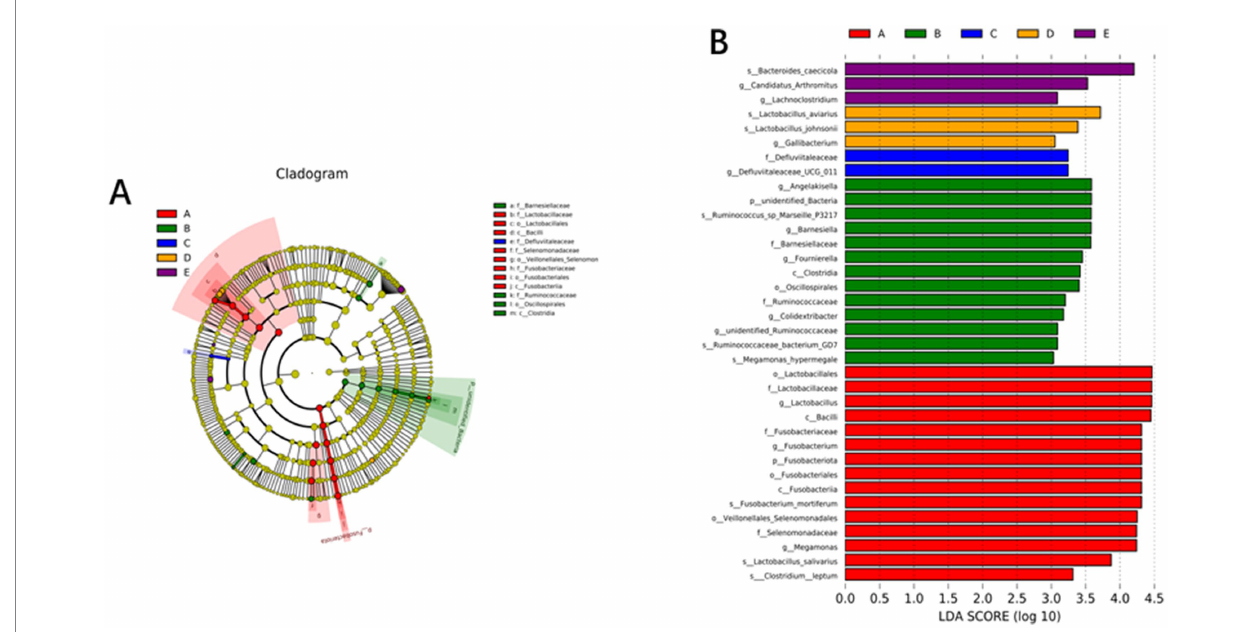
FIGURE 3 Cladogram (A) and LDA value distribution histogram (B) . The bacterial taxa were significantly differentiated among treatments using linear discriminant analysis coupled with effect size (LEfSe) with the default parameters (threshold